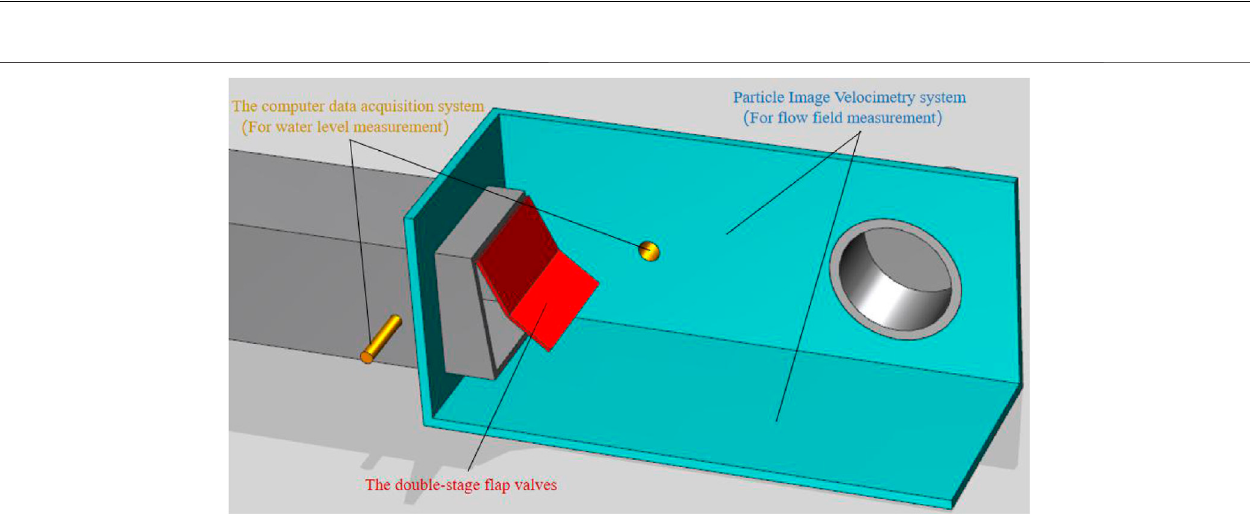
FIGURE3| Diagramofthemodeltestdevice:(1)pump,(2)connectingpipe,(3)controlgatevalve,(4)steady fl owplate,(5)pressure-measuringnode,(6)plexiglass tube, (7) gradient tube, (8) transparent square box, (9) fl ap valve body, and (10) transparent outlet pipe.